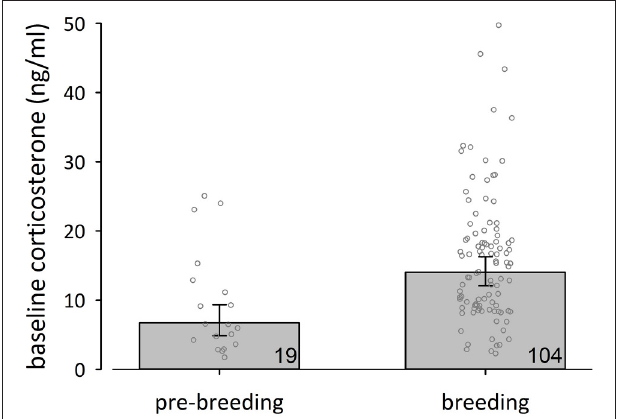
FIGURE 2 | Back-transformed posterior means ( ± 95% credible intervals) of baseline corticosterone concentrations of female black coucals were lower during the pre-breeding than during the breeding period. Numbers inside bars refer to sample sizes, and jittered dots represent individual data points.